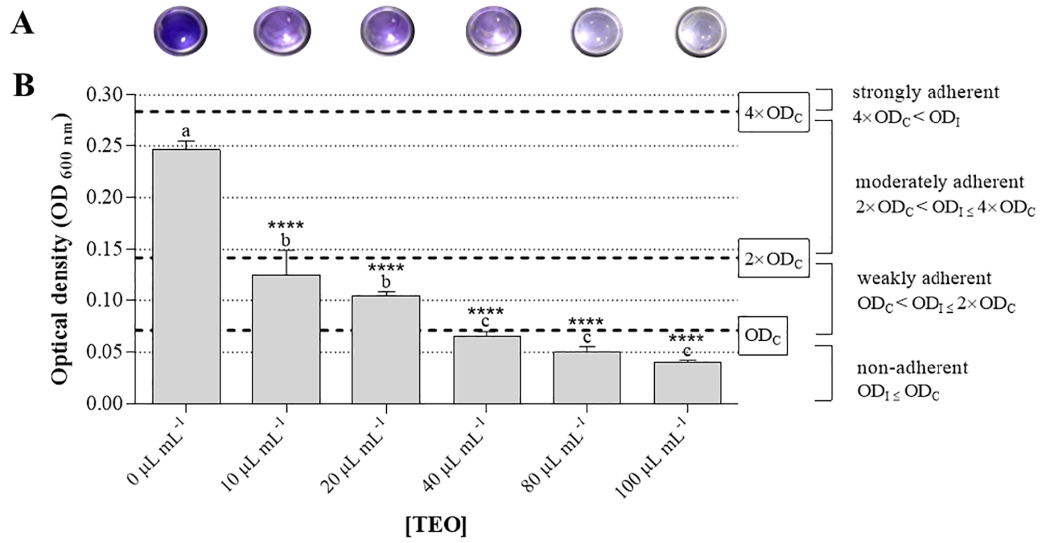
Figure 4. Adherence levels of B. cereus BC3 food isolate. ( A ) Biofilm biomass at the bottom of multi- well plates in the presence and absence of increasing concentrations (10, 20, 40, 80, 100 µL mL − 1 ) of TEO. ( B ) Optical density (OD) values, detected by absorbance reading at a wavelength of 600 nm with a microplate reader, of bacterial biofilms developed by B. cereus BC3 in the presence and ab- sence of increasing concentrations (10, 20, 40, 80, 100 µL mL − 1 ) of TEO. The comparison with nega- tive control, represented by the broth medium, allowed to determine the level of adherence for each experimental condition. One-way ANOVA test was performed to evaluate statistical significance. Bars comparison with positive control bar (absence of TEO) was analyzed by Dunnett ’ s post hoc